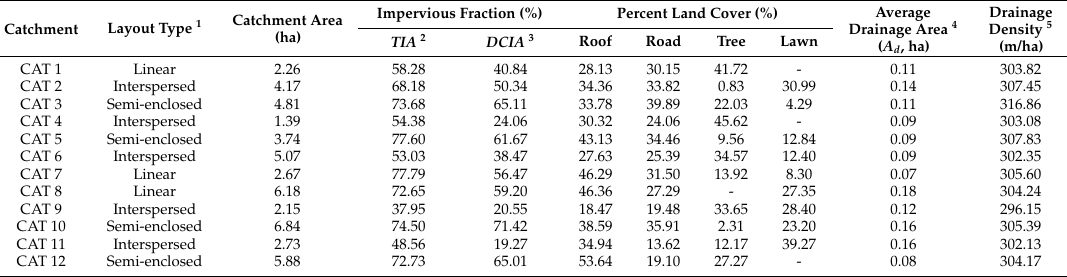
Figure 2. Impervious and drainage layouts of the twelve residential catchments. Table 1. Summary of spatial and drainage characteristics of the twelve study sites.